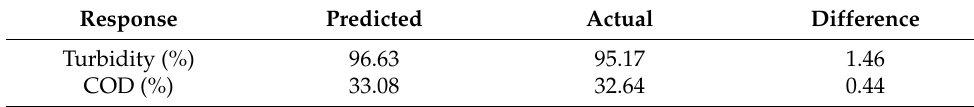
( b ) Figure 8. ( a ) Actual vs. predicted values of optimal turbidity removal; ( b ) Actual vs. predicted val- ues of optimal COD removal. Table 10. Modified RSM-CCD optimum conditions experimental validation. Response